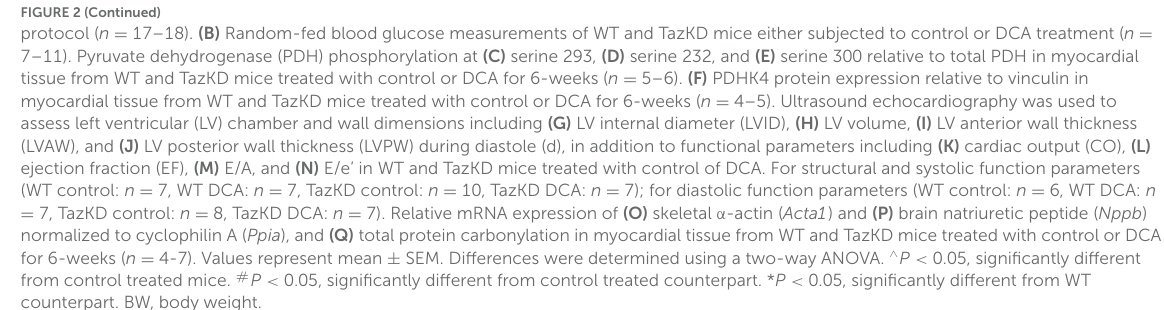
TABLE 2 In vivo assessment of cardiac structural and functional parameters in WT and TazKD mice following treatment with DCA. WT WT TazKD TazKD Control DCA Control DCA 400 ±